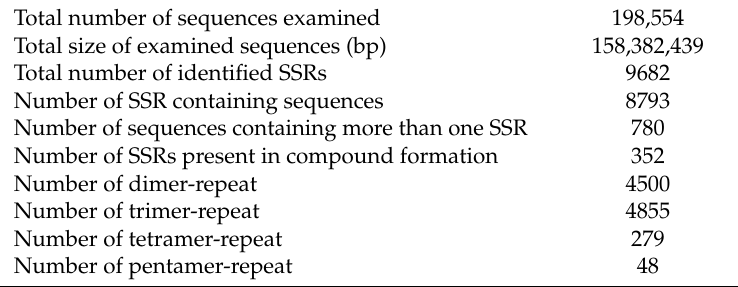
Table 3. In silico identification of microsatellites from the mixed tissue assembly. SSR, simple sequence repeat.